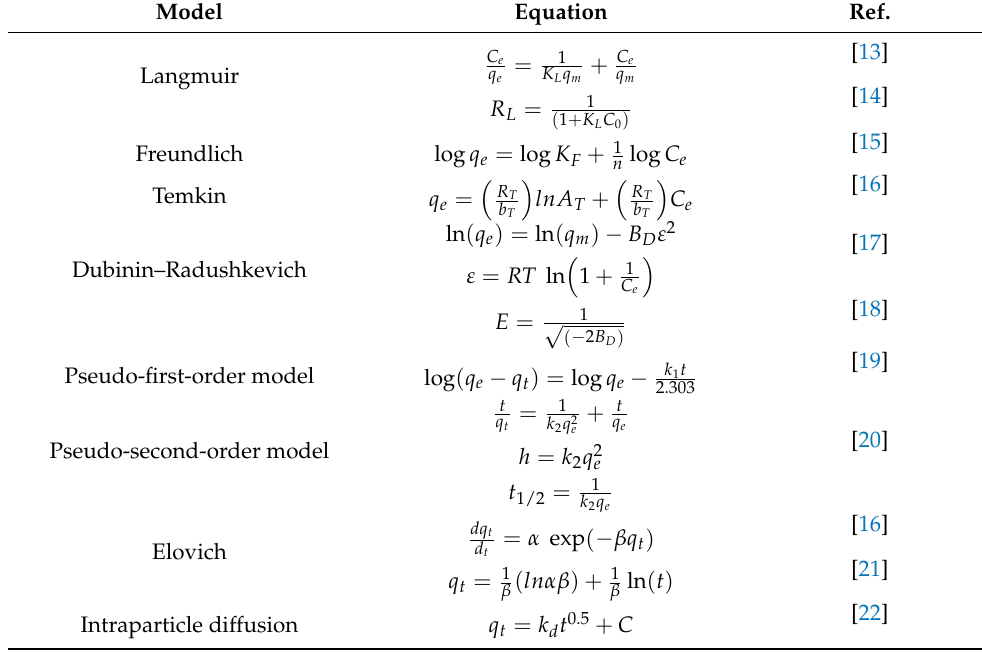
Table 1. Several isotherms, kinetic and thermodynamic model equations commonly used in adsorp- tion studies 1